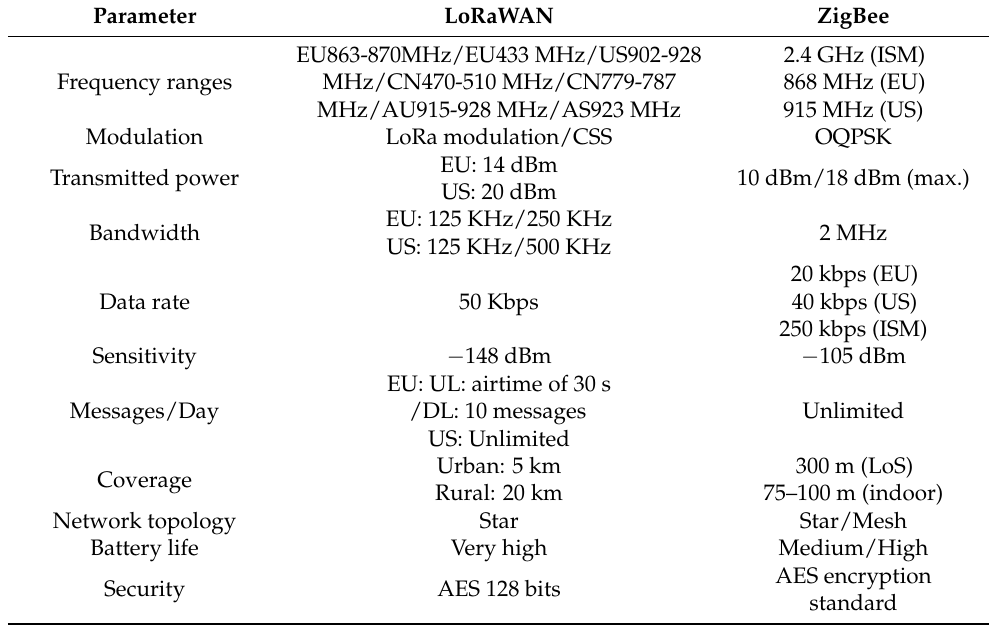
Table 3. Overview of LoRaWAN and ZigBee